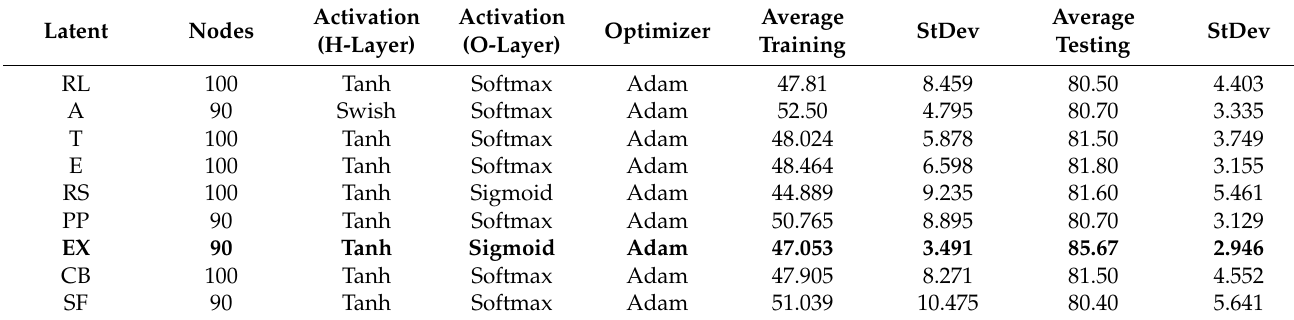
Table 8. Summary of Initial DLNN